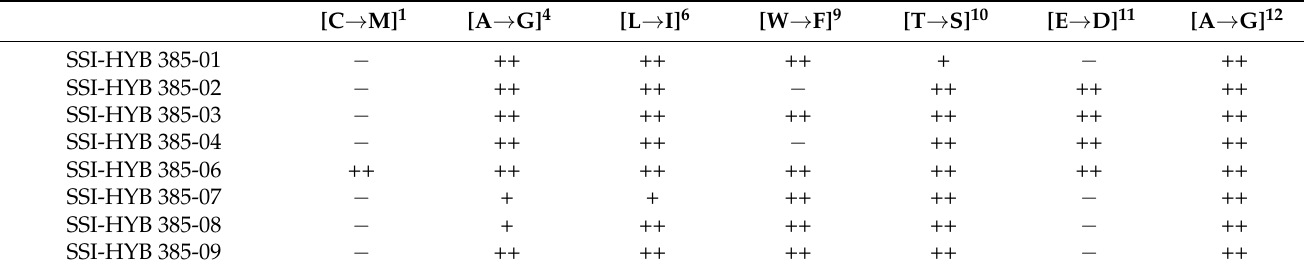
Table 3. SSI-HYB reactivity to functionality-substituted peptides. The amino acids in brackets represent the substitution introduced. The peptide CREAALQGWTEA was used for generation of substituted peptides. ++ represents reactivity similar to the control, + represents medium reactivity, − represents no